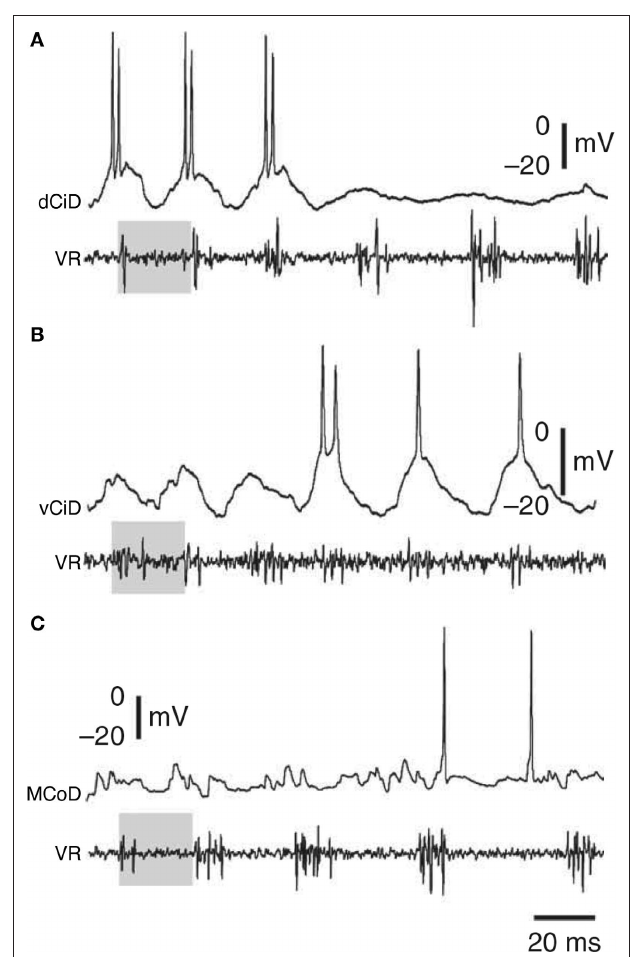
Figure 6 | examples of zebrafish interneurons activated as a function of swimming speed. As speed decreases, first (A) dorsal circumferential descending interneurons (CiDs), then (B) ventral CiDs, and then (C) multipolar commissural descending interneurons (MCoDs) become active. VR, ventral root. Adapted from McLean et al. (2008) Nat. Neurosci. 11: 1419-1429, with permission of